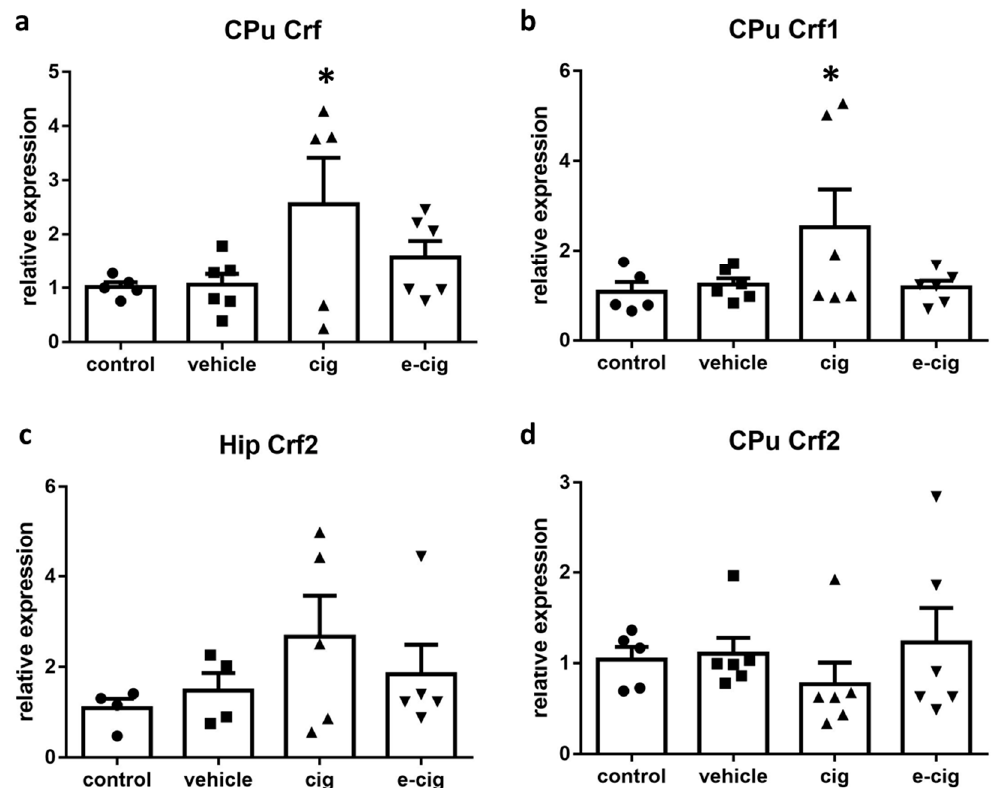
Figure 2. Relative mRNA levels of Crf ( a ), Crf1 ( b ), or Crf2 ( c , d ) after e-cigarette (e-cig, downward triangle) or cigarette (cig, upward triangle) exposure with respect to the exposure to air (control, circle) or the e-cigarette administration vehicle (vehicle, square). The results displayed in panels ( a , b , d ) were obtained in the CPu, while panel c shows the results obtained in the hippocampus. The mice were exposed to cigarettes or e-cigarettes for 7 weeks, followed by a 60-day withdrawal. n = 4–6 for each group. *: p < 0.05 in the Planned Comparison vs. control. Hip: hippocampus, CPu: caudate-putamen.